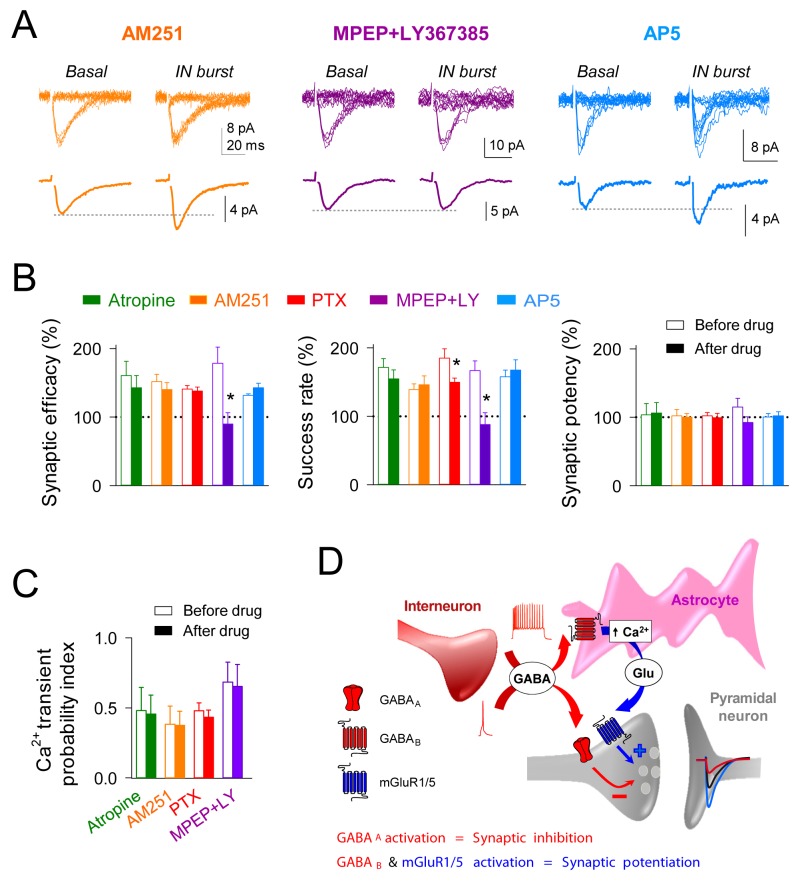
Interneuron-induced synaptic potentiation requires astrocytic GABAB receptor and presynaptic mGluR activation.(A) Synaptic responses evoked by minimal stimulation (15 consecutive stimuli; top) and averaged EPSCs (bottom) before and after evoking bursts of interneuron APs in presence of AM251 (orange), MPEP+LY367385 (magenta), and AP5 (Blue). (B) Relative changes of synaptic parameters induced by bursts of interneuron APs before (open bars) and after (filled bars) receptor antagonist application (n ≥ 5 neurons for each bar). *p<0.05; paired t test. (C) Astrocyte Ca2+ transient probability index after evoking bursts of interneuron APs, before (open bars) and after (filled bars) receptor antagonist application (n ≥ 5 slices for each bar). (D) Scheme of the proposed mechanisms for GABAA mediated synaptic inhibition and GABAB-mGluR group I induced synaptic potentiation, respectively.